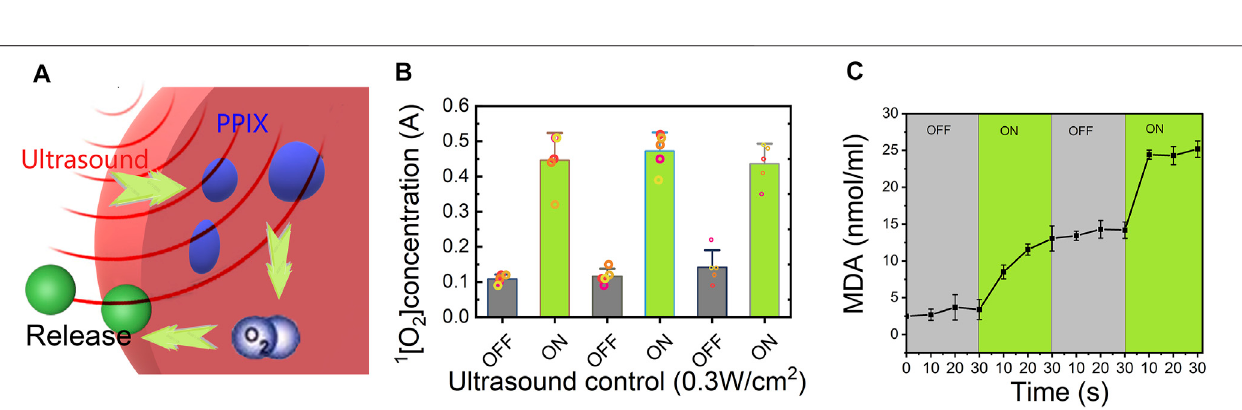
FIGURE 5 | Release mechanism of the Lido-PPIX@ER hydrogel under ultrasound. (A) Schematic representation showing the ultrasound-regulated release of lidocainefromtheLido-PPIX@ERhydrogel. (B) Concentrationpro fi leofsingletoxygenwithultrasound(0.3 W/cm 2 )intheon/offstate. (C) MDAconcentrationchangesof the Lido-PPIX@ER hydrogel under ultrasound regulation (on-off state) at 37 ° C.